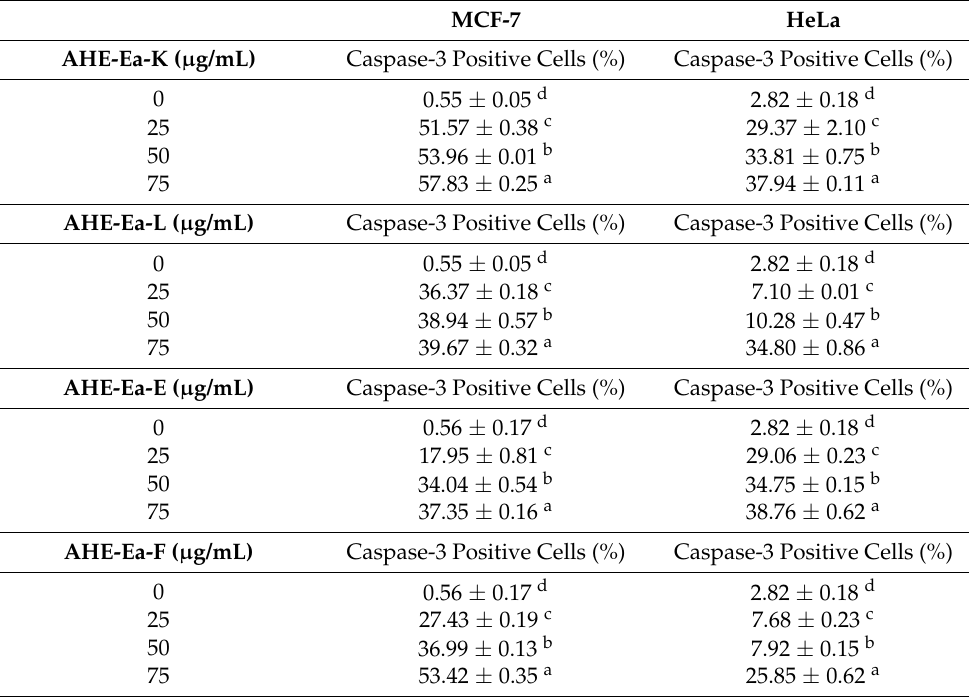
Table 4. The effects of 48 h of adlay extract subfractions (AHE-Ea-K, AHE-Ea-L, ATE-Ea-E and ATE-Ea-F) treatment on the activity of caspase-3 in MCF-7 and HeLa cells 1,2